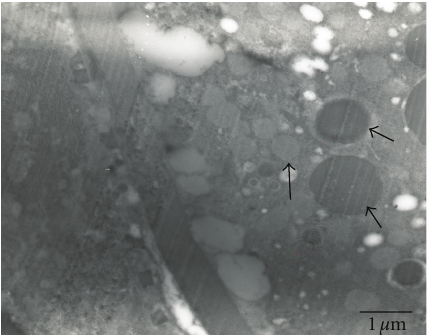
Figure 3: TEM micrograph of the testis of pupa C. megacephala showing thick testis wall covering underdeveloped germ cells with variable size and density of electron-dense globules